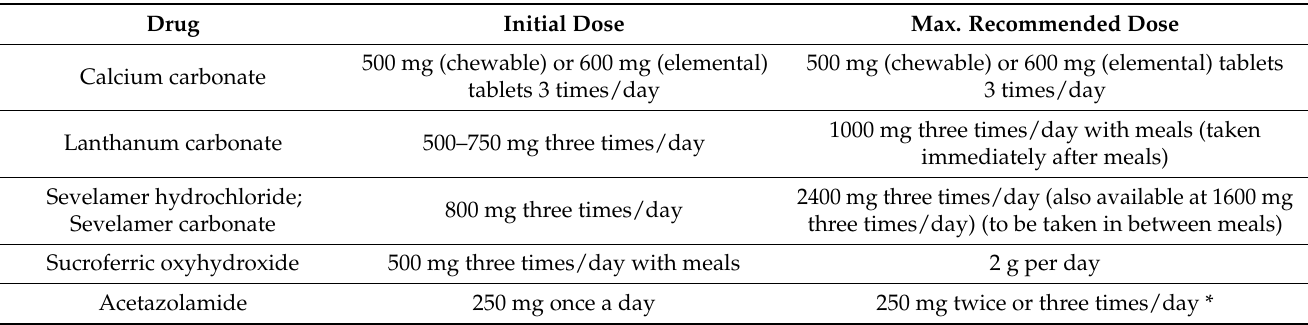
Table 4. Dosing considerations of phosphate lowering